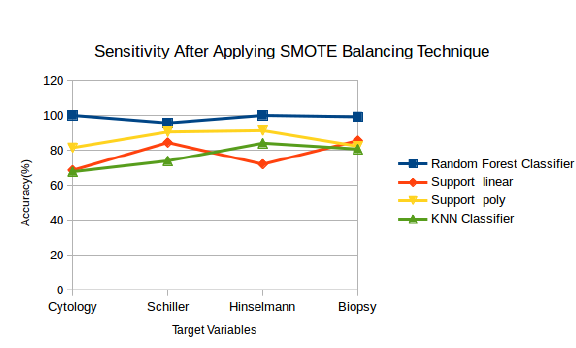
Figure 6. Comparative analysis of Accuracy